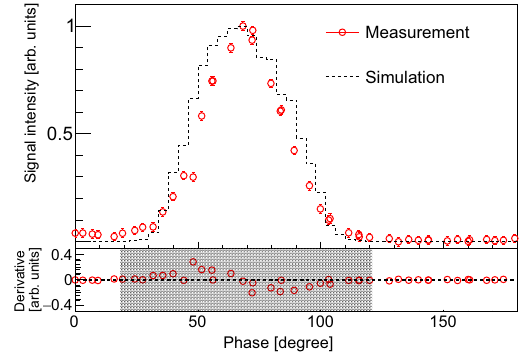
FIG. 8. Longitudinal phase distribution measured using HOPG-BSM in the test stand. The size of the HOPG target was 0 . 2 ð width Þ × 1 . 0 ð thickness Þ mm 2 and the lens voltage was 3.5 kV. The black hatched region indicates the range adopted for evaluating the longitudinal bunch